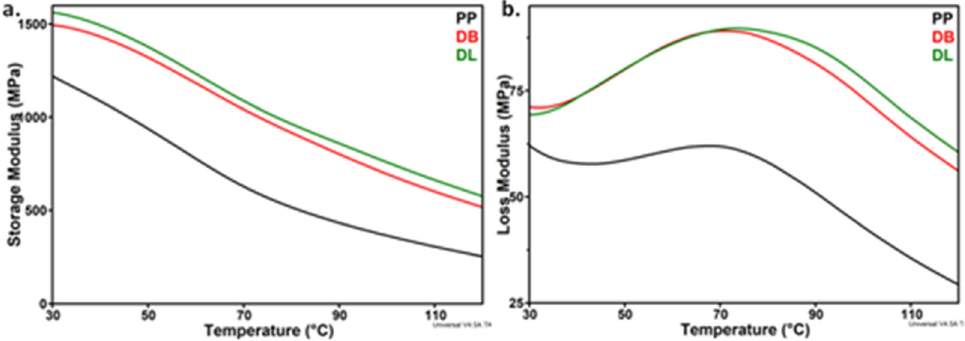
Figure 12. Storage modulus ( a ) and loss modulus ( b ) vs. temperature for PP hybrid composites, DB and DL, compared with neat PP.